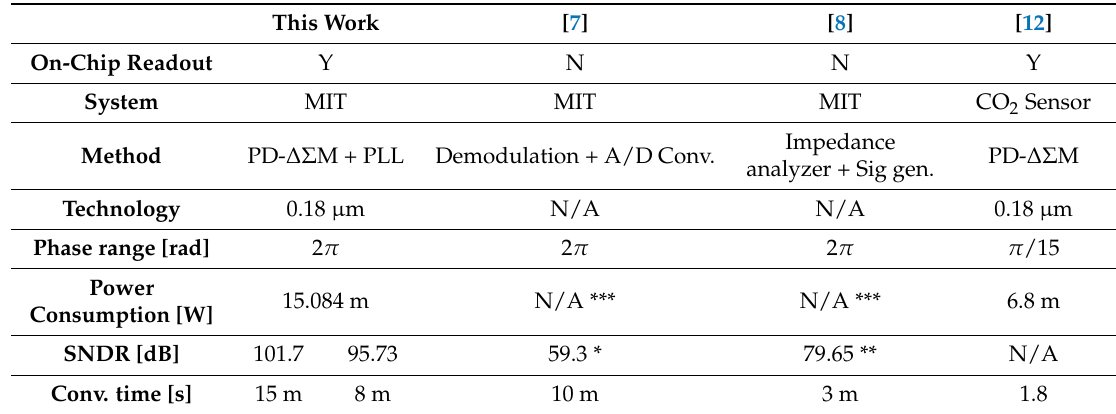
Figure 8. ( a ) Experimental snapshot of proposed phase-domain MIT system prototype and ( b ) measured characteristic plot of phase shift with different material types. Table 1. Performance summary and comparison table.